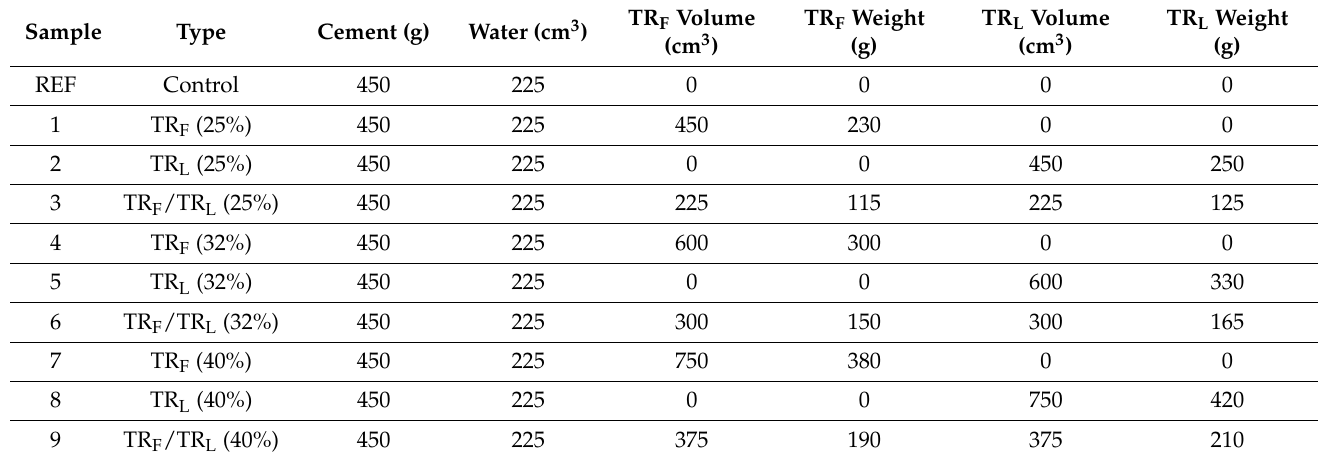
Table 2. TR mortar composition.